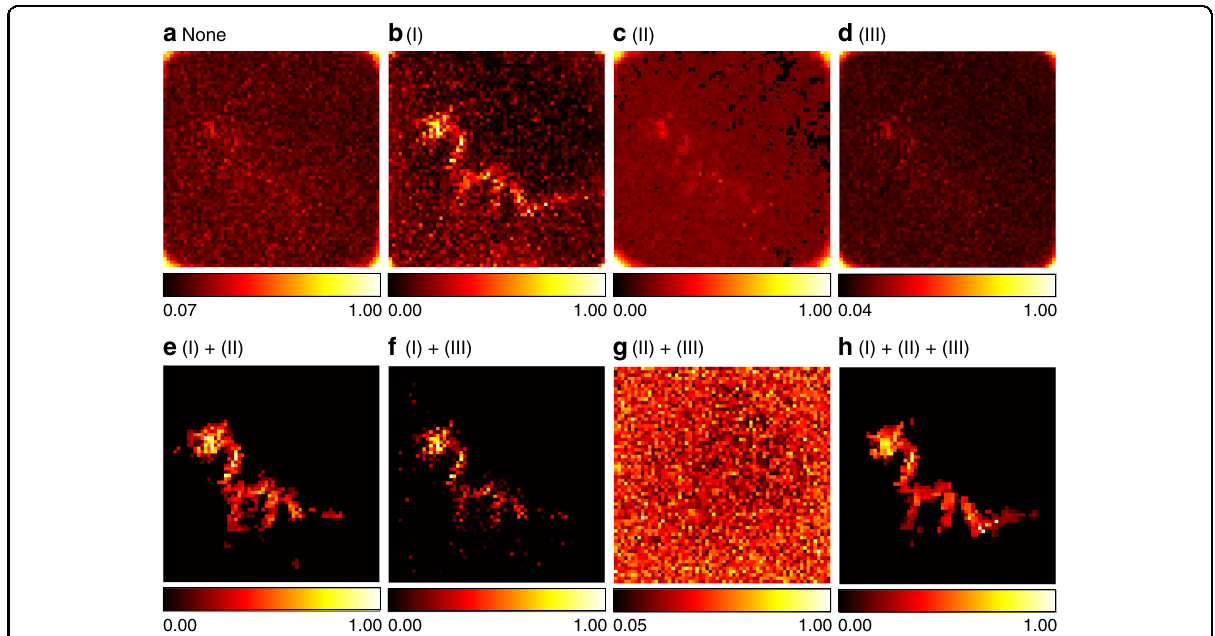
Fig. 16 Reconstruction results of the dragon with different regularizations (confocal, 15s). Reconstruction without regularization is shown in a . Reconstructions with different regularization settings are shown in b – h . The measurements contain heavy noise due to extreme short exposure time. The specularity of the material also makes the physical model deviate from the measurement process. The proposed joint signal – object prior is a combination of three priors, namely (I) the sparseness prior of the target, (II) the non-local self-similarity prior of the target, and (III) the smoothness prior of the